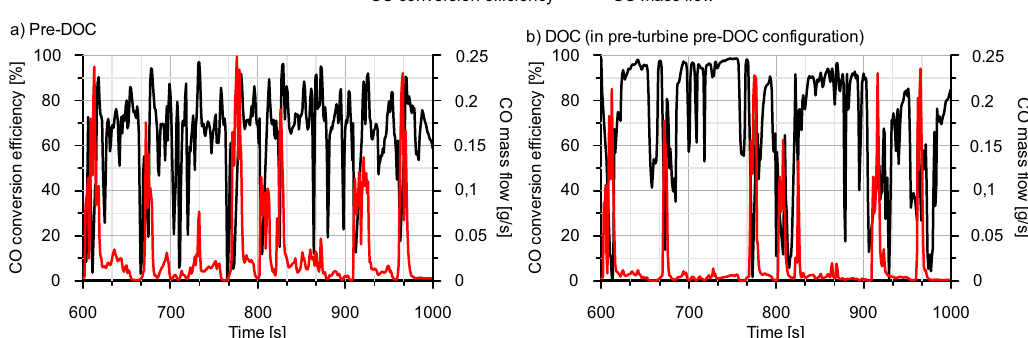
Figure 11. Instantaneous CO conversion efficiency and mass flow in ( a ) pre-DOC and ( b ) DOC (pre-turbine pre-DOC configuration) during the medium speed phase of the cold